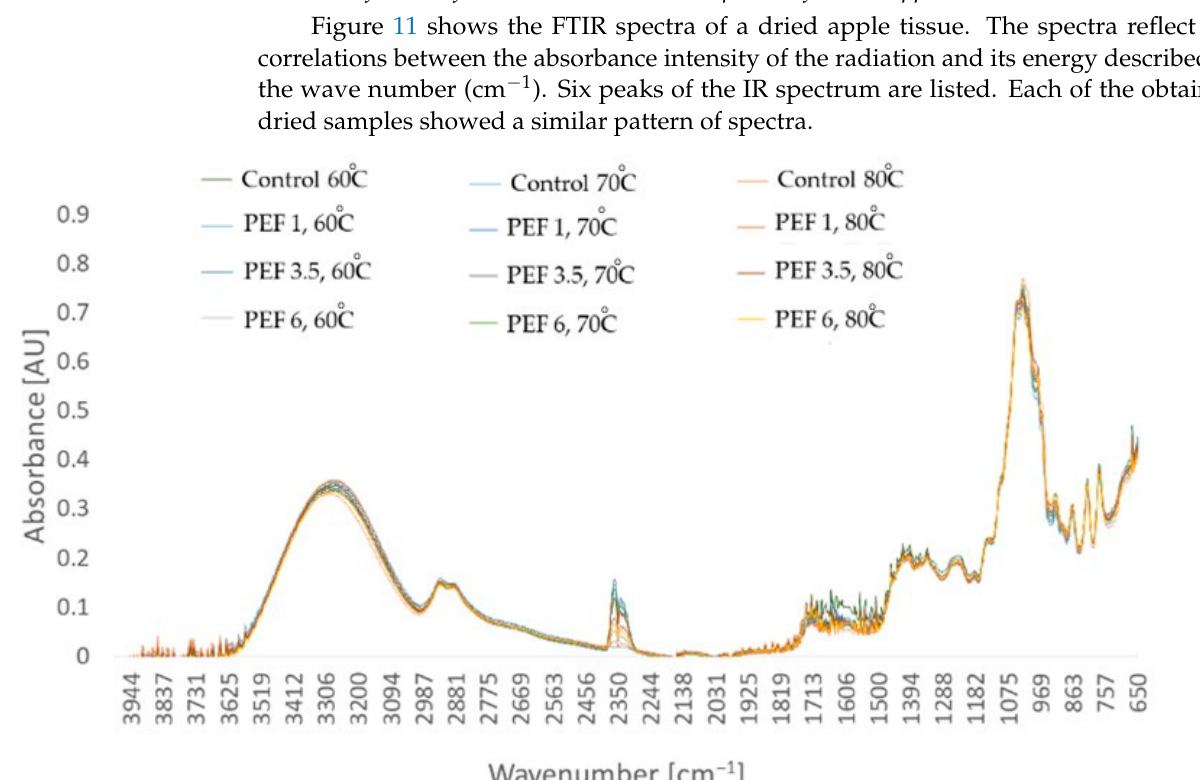
Figure 11. FTIR spectra of dried apple tissue obtained using different values for the parameters of pulsed electric field intensity (1, 3.5, and 6 kJ/kg) and hot air drying temperature (60, 70, and 80 ◦ C). The columns with different letters are significantly different ( p < 0.05).